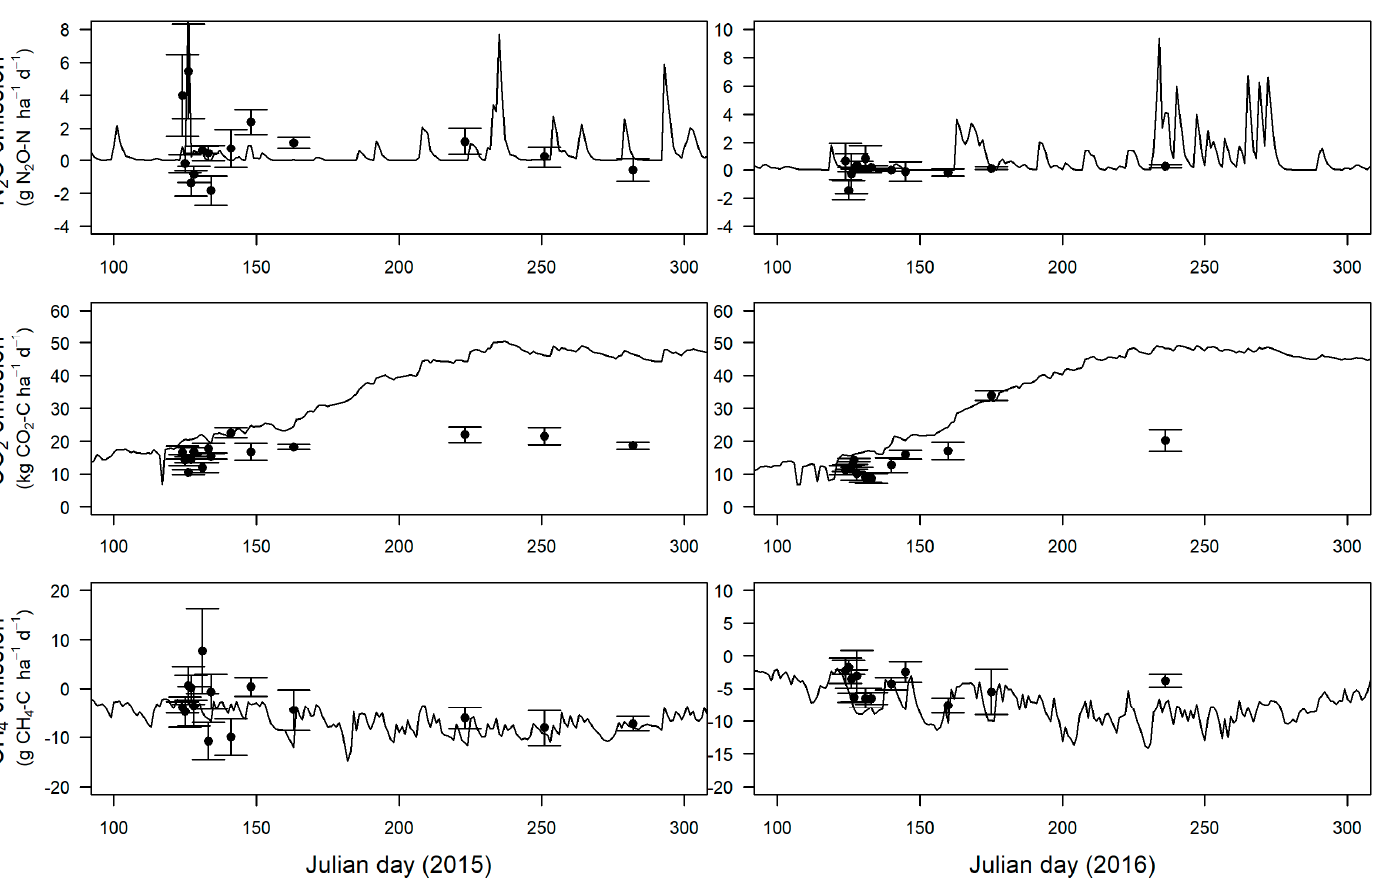
Figure 1. Measured (filled circle) and simulated (solid line) N 2 O, CO 2 and CH 4 emissions from soils of the cutting treatment for 2015 and 2016 growing seasons. Error bars are standard deviations for 5 replicates.